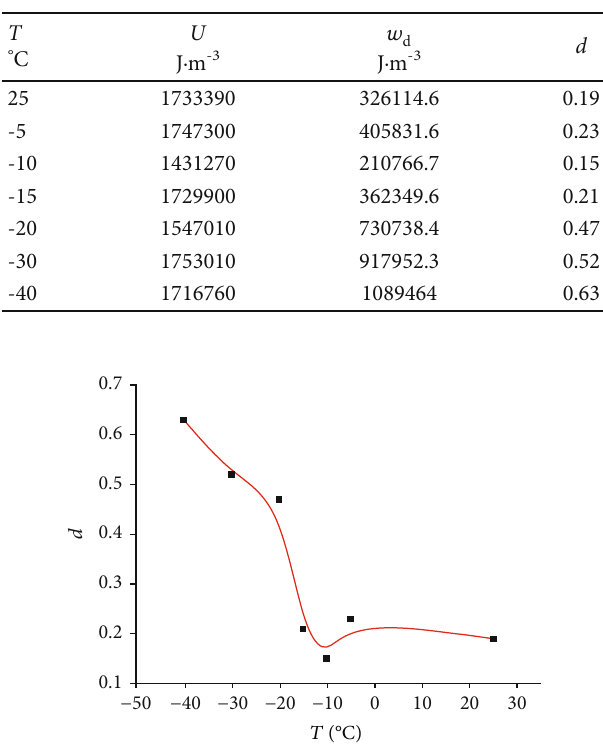
Figure 9: Transmitted, dissipated energy vs. temperature for granite. Table 3: Damage variable vs. temperatures under dynamic impact for